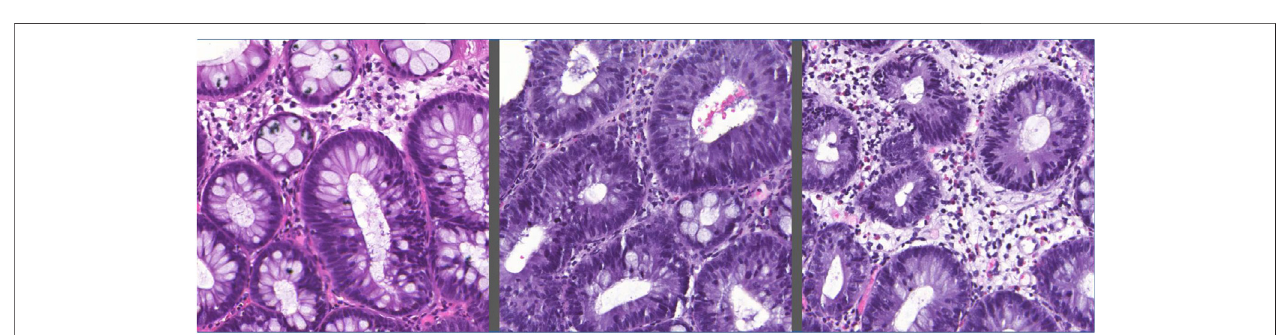
FIGURE 2 | Examples of adenomatous colon tissues.